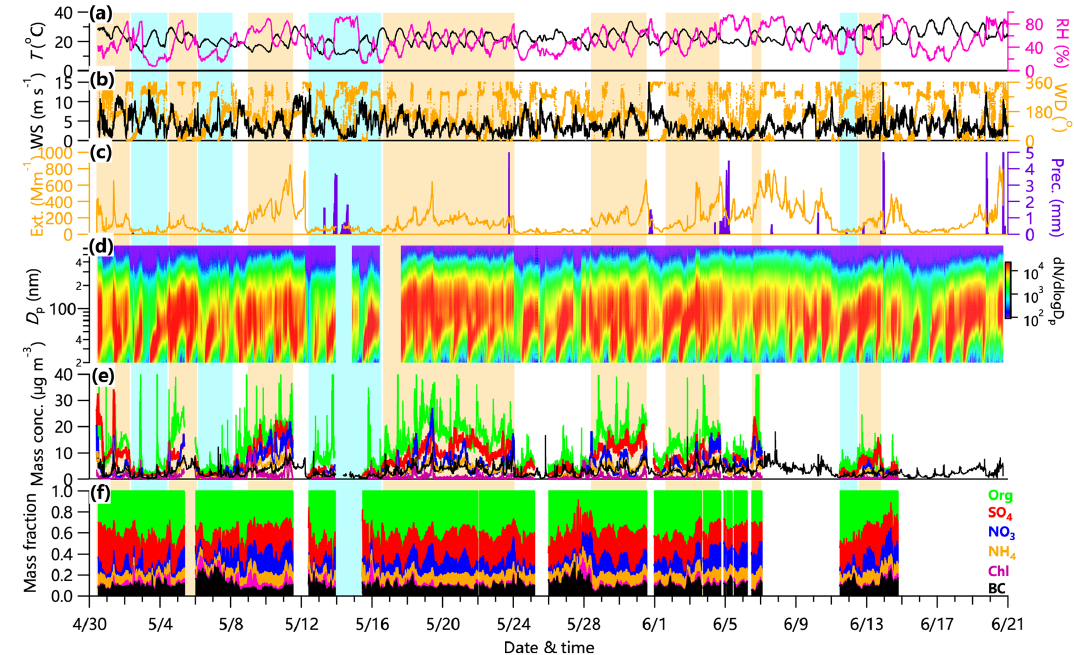
Figure 3. Time series of (a) temperature ( T , in black) and relative humidity (RH, in magenta), (b) wind direction (WD, in orange) and wind speed (WS, in black), (c) particle extinction coefficient (Ext., in orange) and precipitation (Precip., in purple), (d) particle number size distribution, (e) mass concentrations of Org, NO 3 , SO 4 , NH 4 , Chl, and BC, and (f) mass fractional contribution of chemical species to total PM 1 . Polluted events (PEs) and clean periods (CPs) are marked as shaded orange and blue areas,